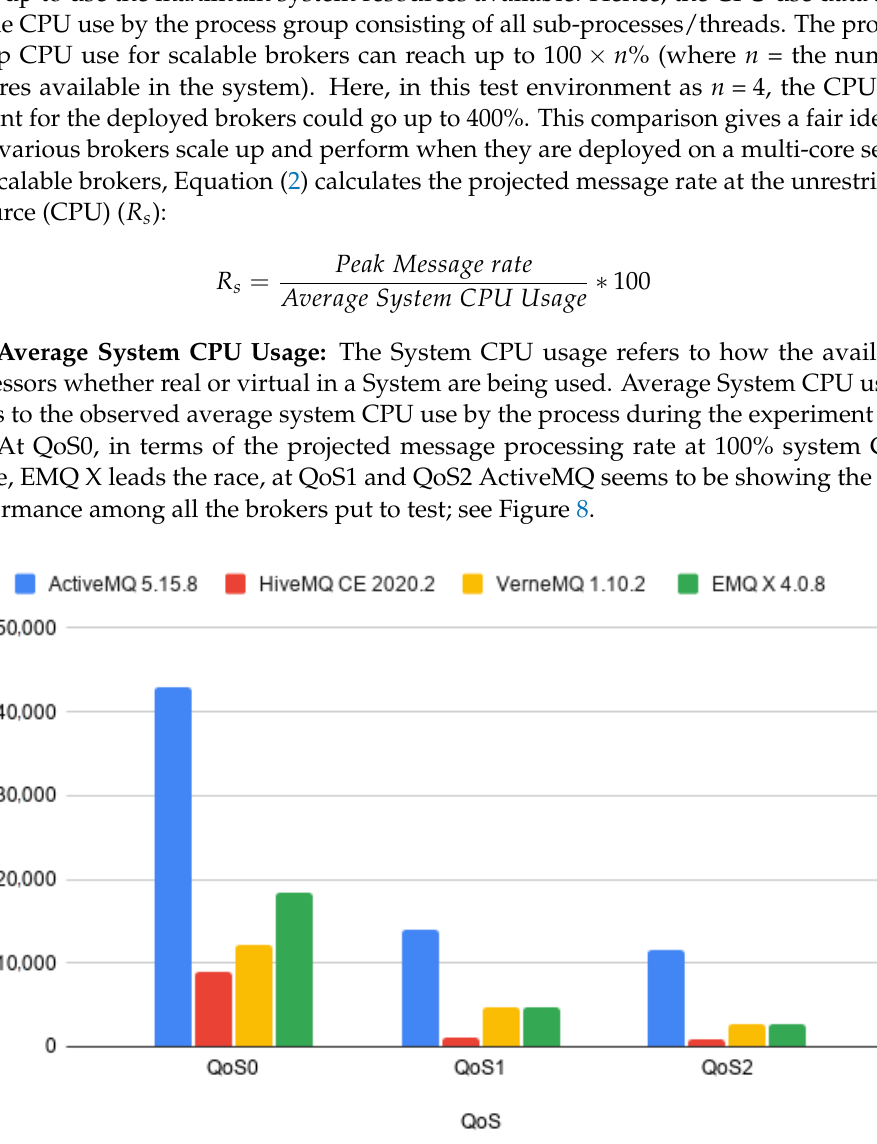
Figure 8. Projected message rate (msgs/sec) of scalable brokers at ˜ 100% system CPU usage in the local evaluation